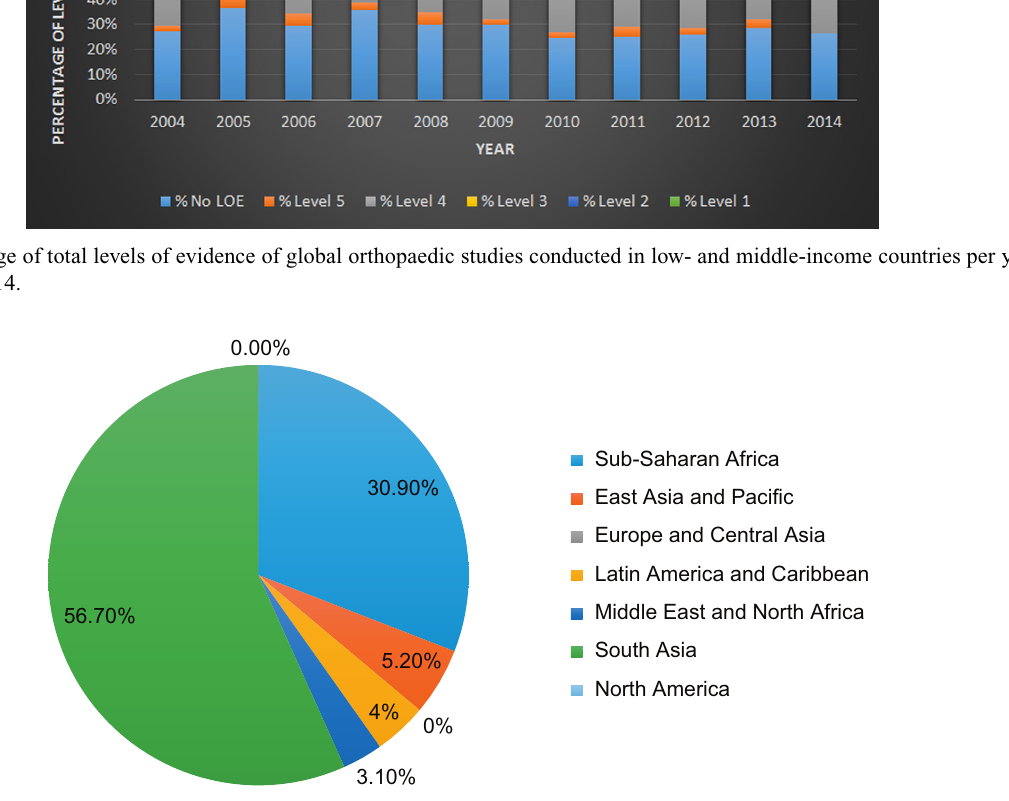
Figure 4. Percentage of high-quality studies (e.g. Levels 1 and 2) published by World Bank Region from 2004 to